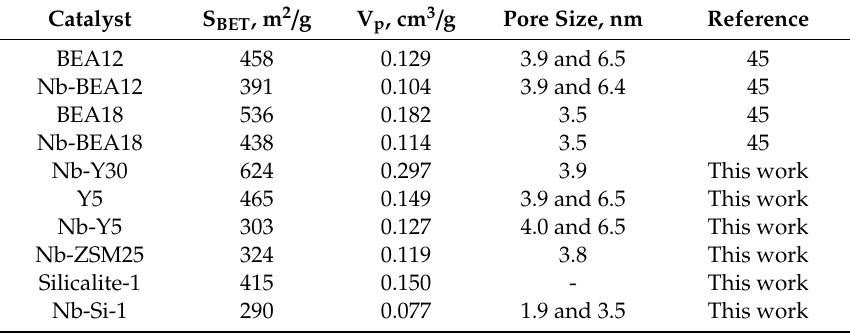
Table 1. Textural properties of the incorporated Nb in molecular sieves’ samples.